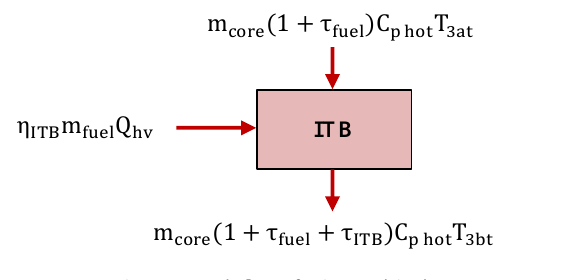
Fig.2. Energy balance for inter turbine